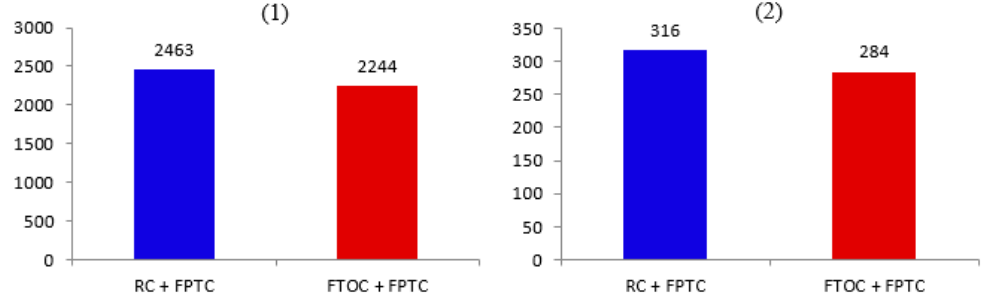
Figure 14. Comparison results of the RC + FPTC vs. the FTOC + FPTC: ( 1 ) energy mode rule of the RC, ( 2 ) R tor of the FTOC, ( 3 ) T doc , ( 4 ) SoC , ( 5 ) total fuel consumption.